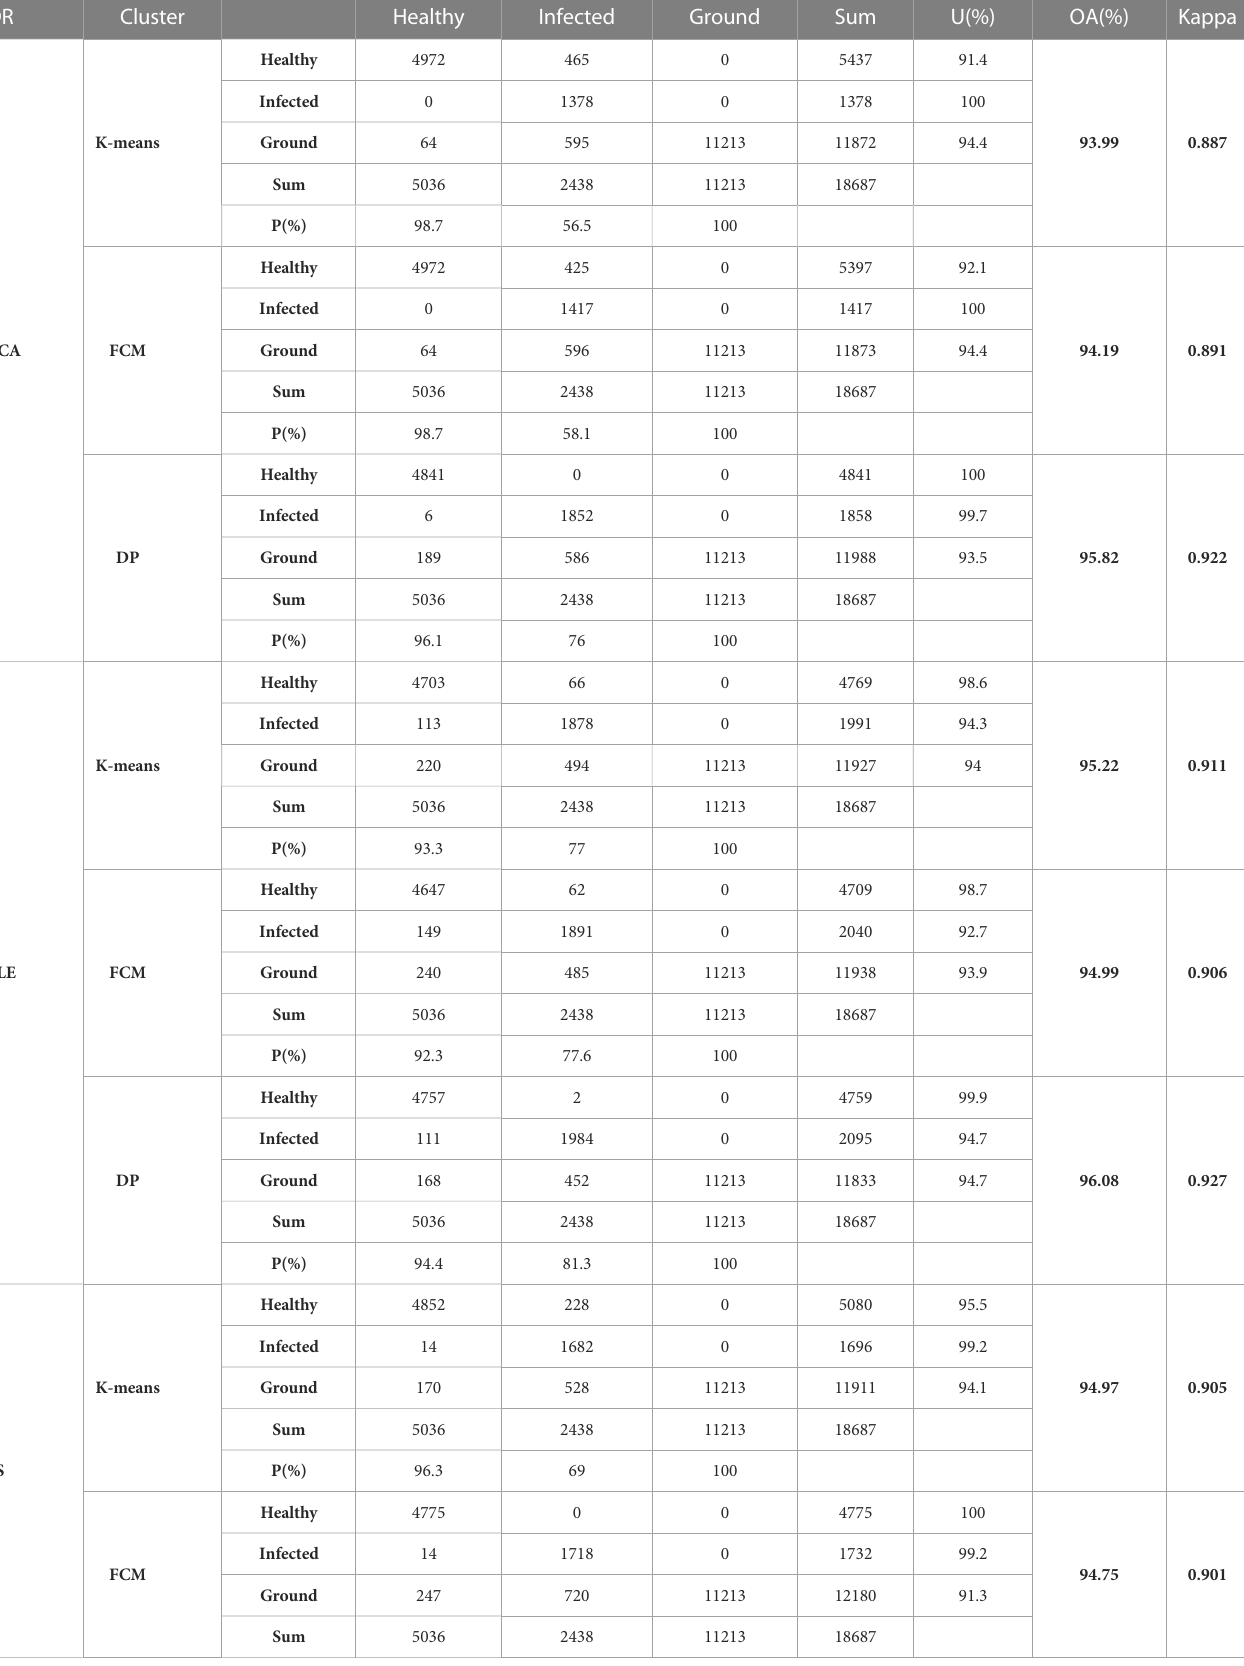
TABLE 2 Accuracy evaluation of each model on the recognition results of infected jujube trees. DR